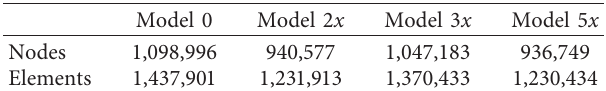
Table 1: The numbers of nodes and elements of the grid in the four computational